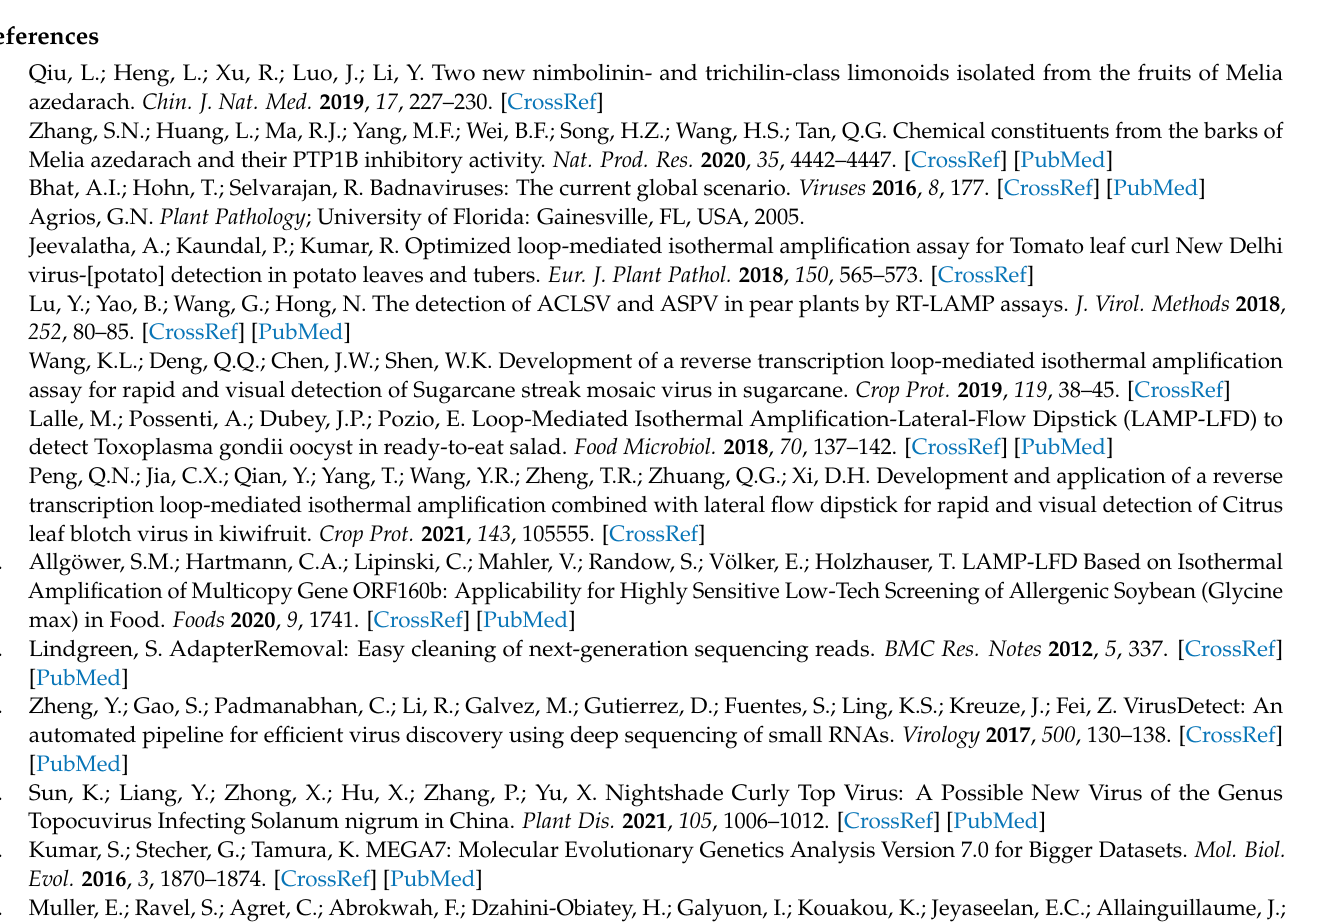
Table S1: List of primers used for cloning of the ChTBV1